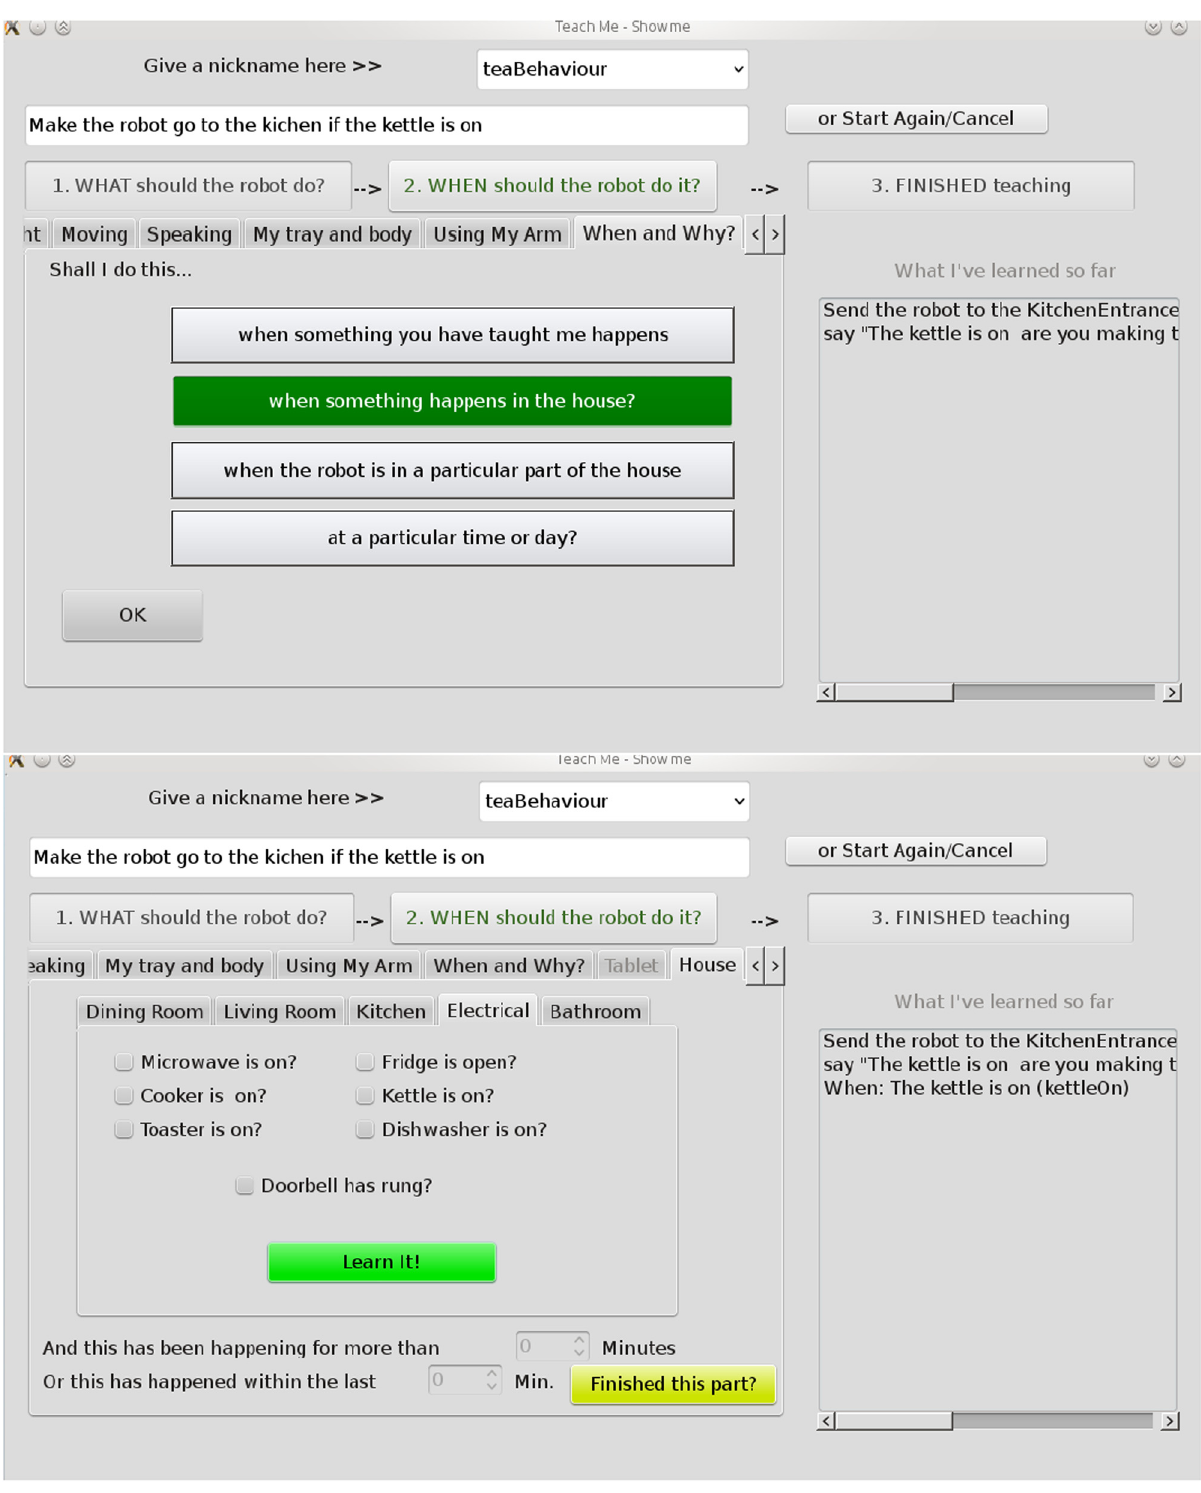
Figure 4: Screenshots of the TEACH M E teaching interface. In the “ When ” phase the user chooses to consider events in the house and clicks on the kettle